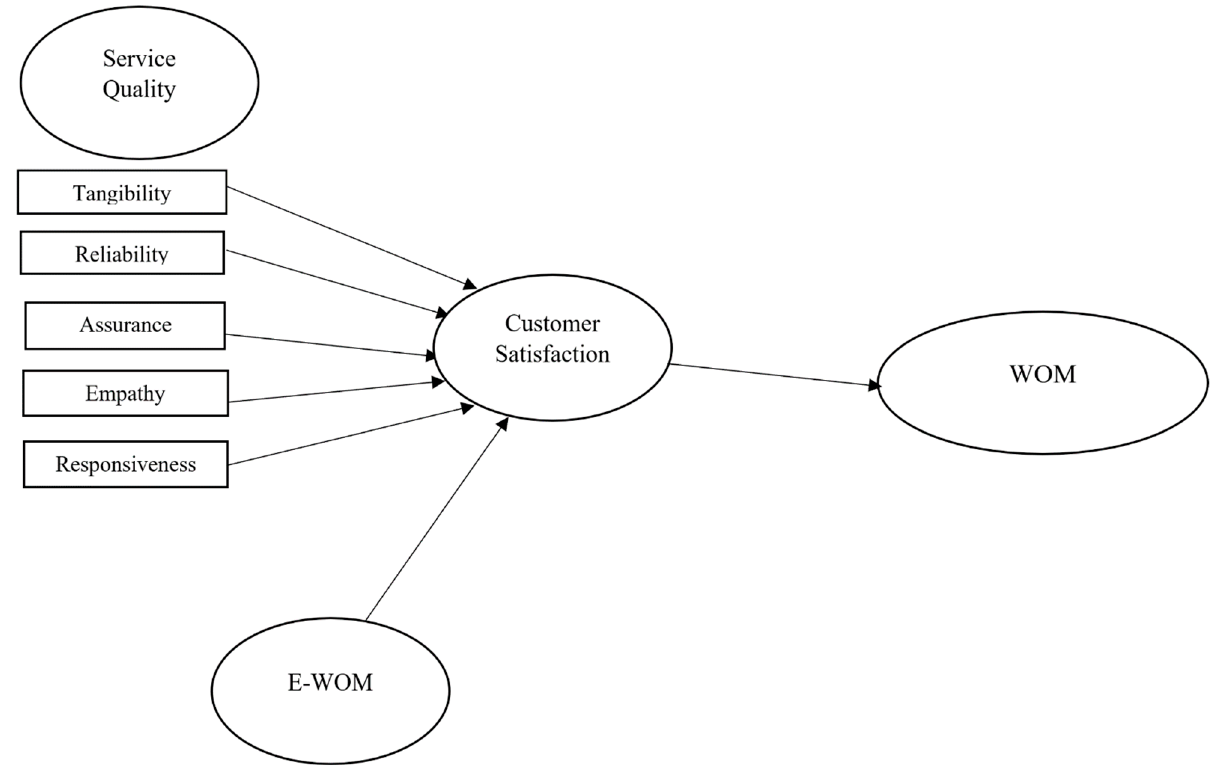
Figure 1. Conceptual research model.